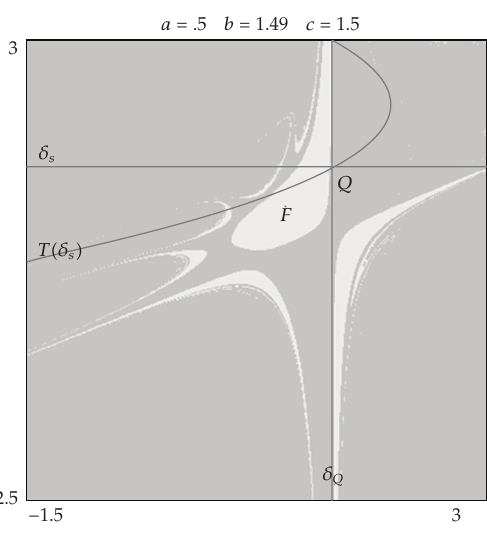
Figure 1: b (cid:2) 1 . 490 basin of attraction non